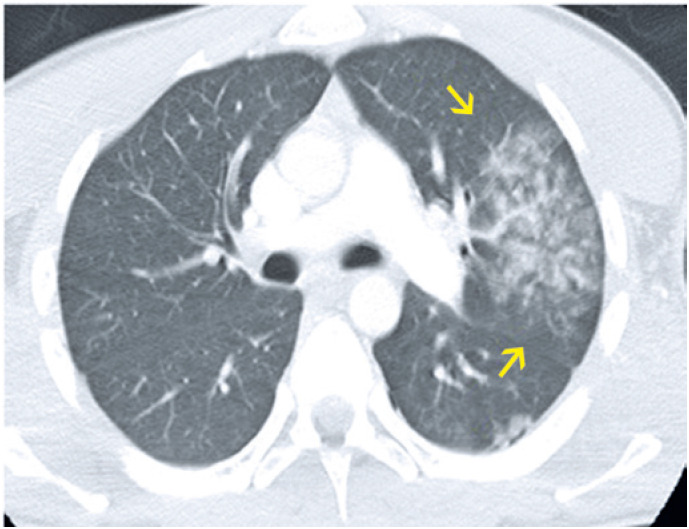
Homem, 19 anos, sofreu queda de moto. Tomografia computadorizada mostra focos de consolidações localizados no lobo superior esquerdo e, em menor grau, no lobo inferior desse mesmo lado. Achados compatíveis com contusões pulmonares dentro do contexto clínico